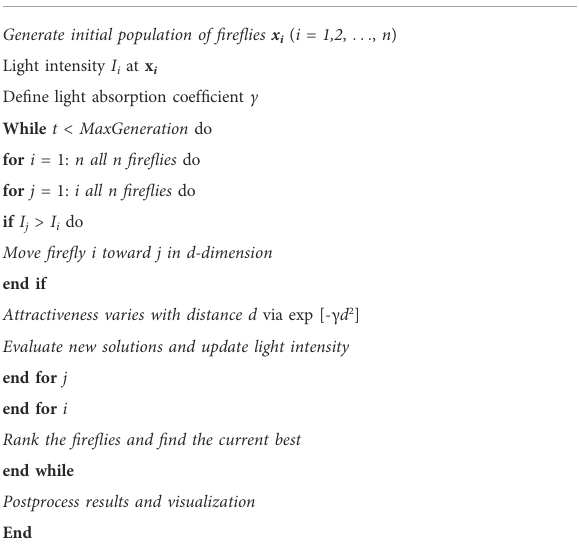
TABLE 1 The pseudo-code of the standard fi re fl y optimization